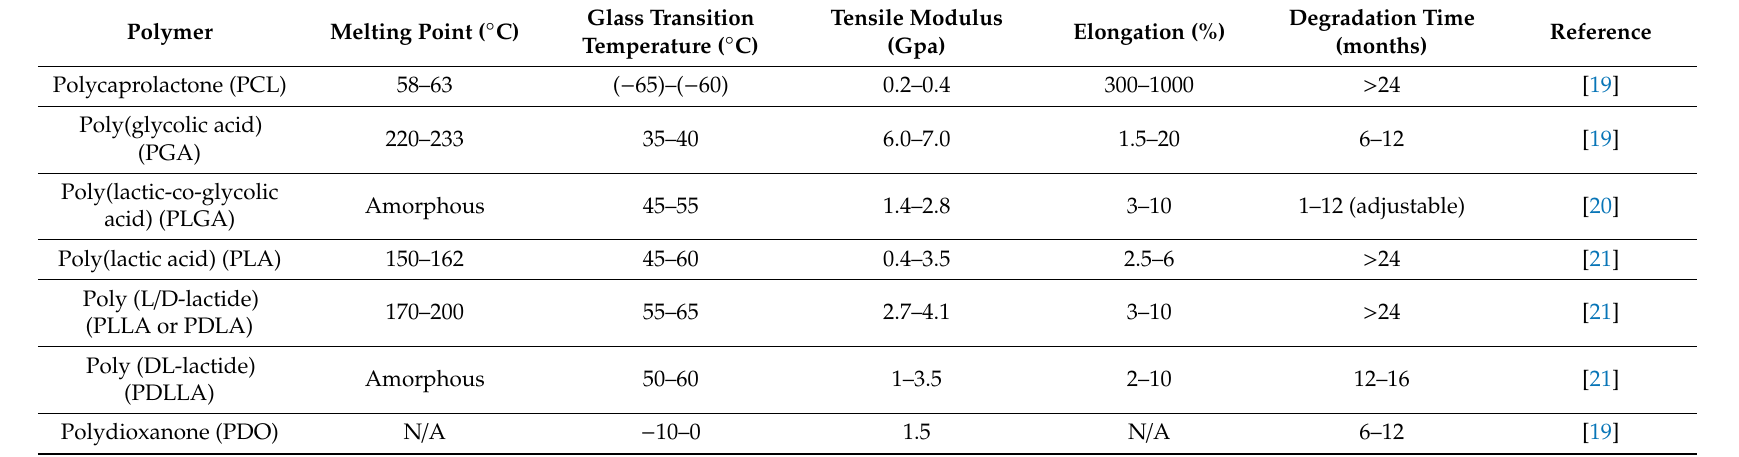
Table 1. Synthetic biodegradable polymers used in tissue engineering: Physical, mechanical and degradation